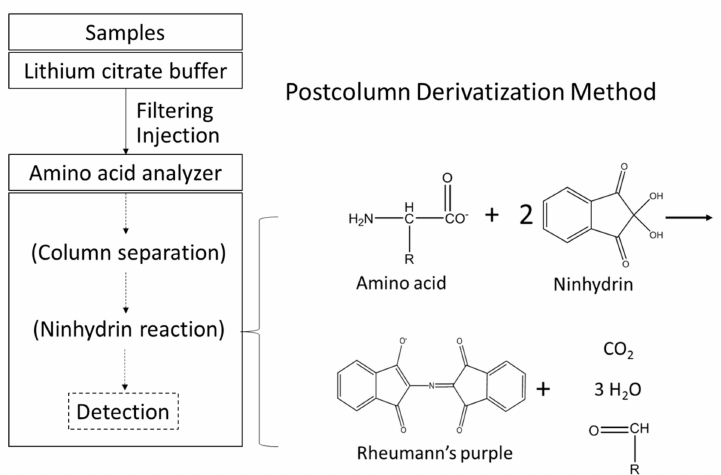
Figure 1. Outline of the amino acid analysis